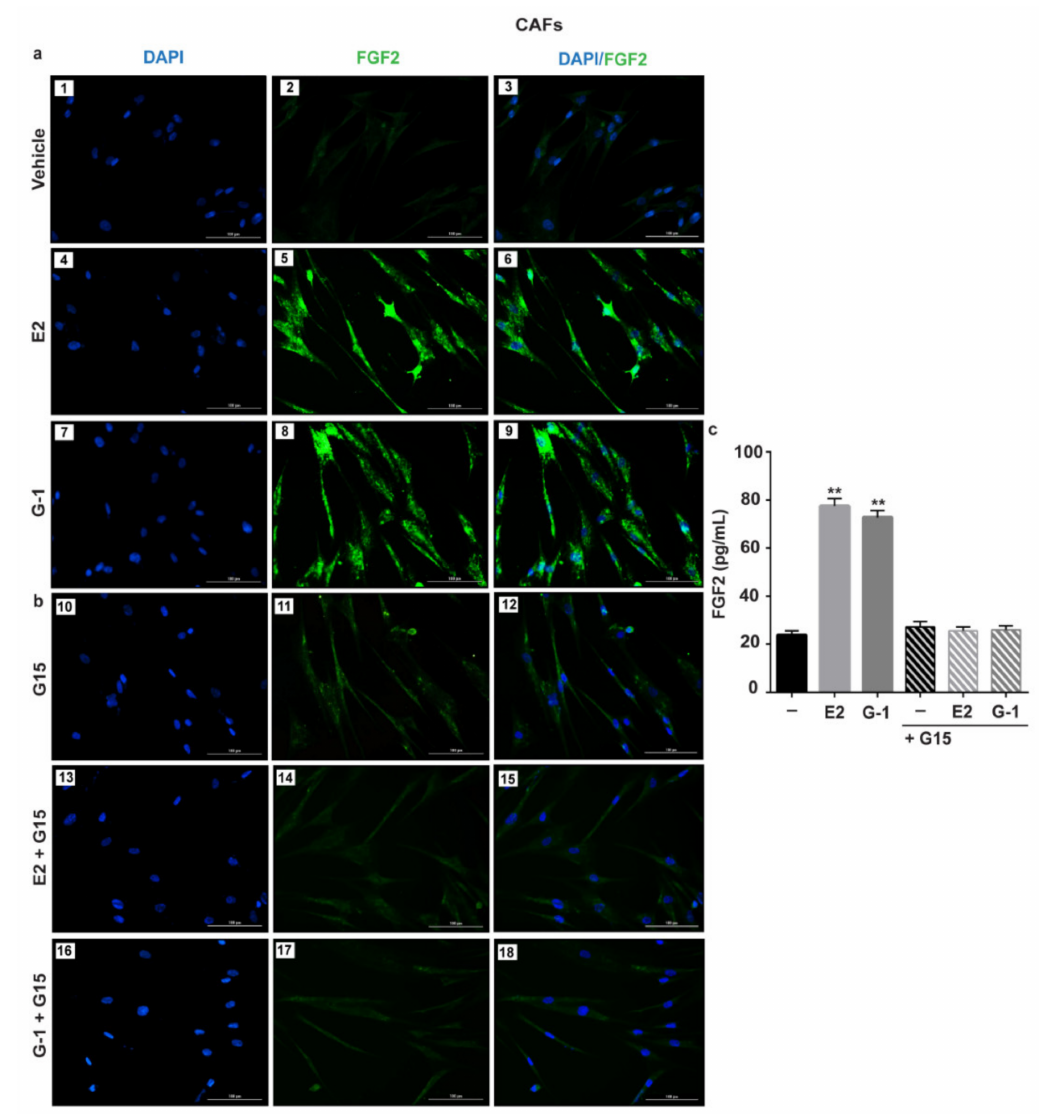
Figure 2. GPER mediates the up-regulation and the secretion of FGF2 by E2 and G-1 in CAFs. FGF2 protein expression by immunofluorescence in CAFs treated for 6 h with vehicle, 10 nM E2 and 100 nM G-1, alone (panels 1–9) ( a ) and in combination with 100 nM GPER antagonist G15 (panels 10–18) ( b ). FGF2 accumulation is shown by the green signal, nuclei are stained by DAPI (blue signal), scale bar = 100 µ m. Images shown are representative of two independent experiments. ( c ) ELISA of FGF2 levels in supernatants collected from CAFs treated for 18 h with vehicle (-), 10 nM E2 and 100 nM G-1 alone and in combination with 100 nM GPER antagonist G15. Each column represents the mean ± SD of three independent experiments performed in triplicate. (**) indicates p <